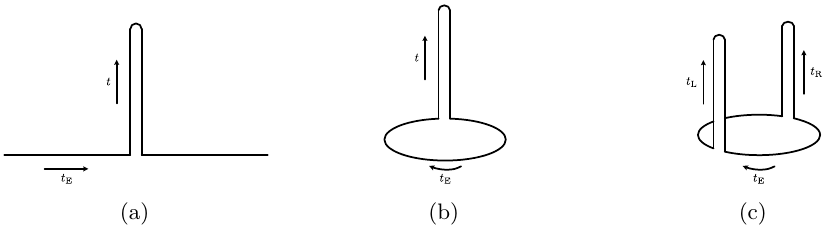
Figure 12 . Schwinger-Keldysh Contours . A Schwinger-Keldysh contour is a contour in the complex time plane that consists of Euclidean caps joined to Lorentzian excursions. The functional integral defined along such a contour computes the expectation value of operators inserted on the Lorentzian section between the initial and final states specified by the Euclidean caps. In field theory, the contour defines the domain on which the fields are defined. In string theory, it is the contour in target space over which the worldsheet functional integral is to be performed. The first contour pictured computes expectation values in a pure state such as the vacuum. The second computes expectation values in a thermal state, and the third in a TFD